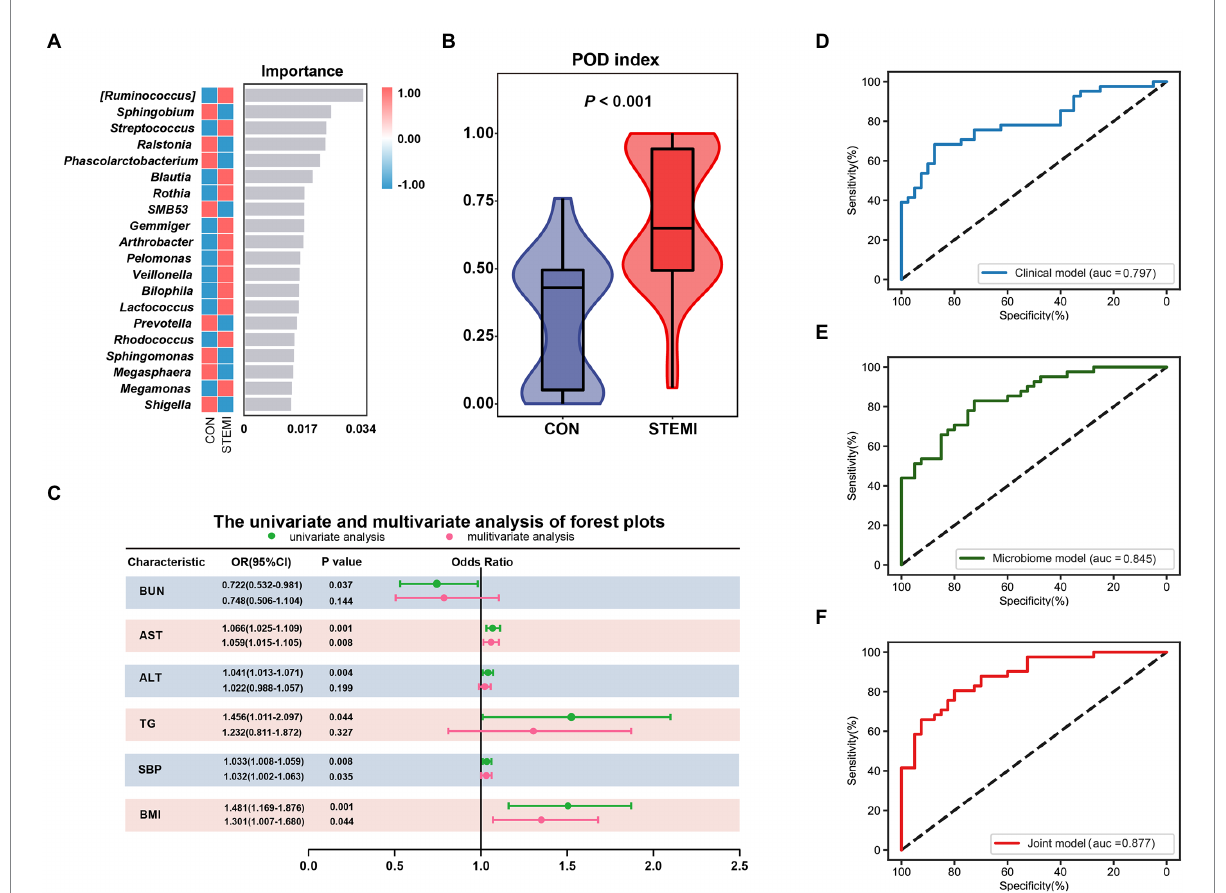
FIGURE 5 Combined prediction model of gut microbiome and clinical variables. (A) The top 20 bacteria belong to the genus level based on the random forest analysis. (B) Comparison of the POD of gut microbiome between the two groups. (C) Candidate variables for clinical model development were presented as forest plots. The AUCs for the diagnostic performances of the clinical model (D) , the gut microbiome model (E) , and combined model